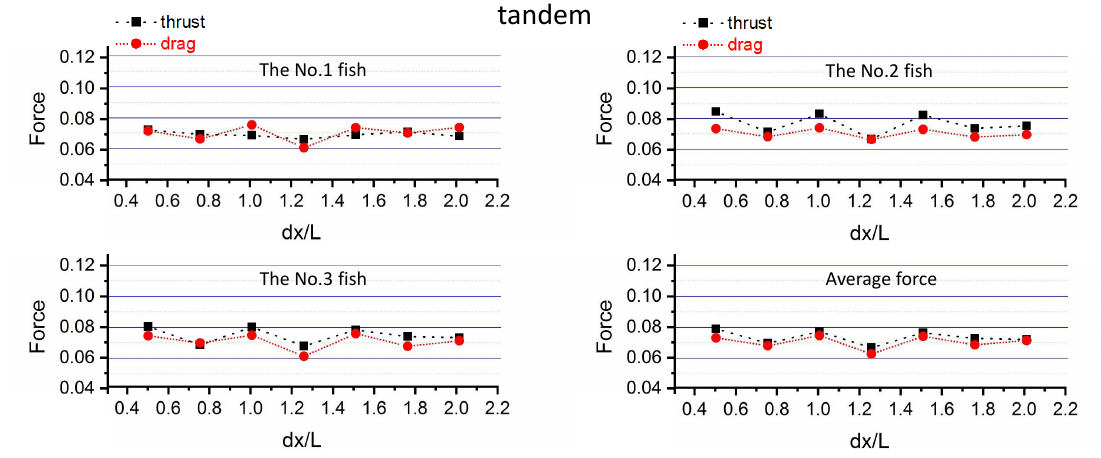
Figure 9. The thrust and drag at different spacing of the tandem